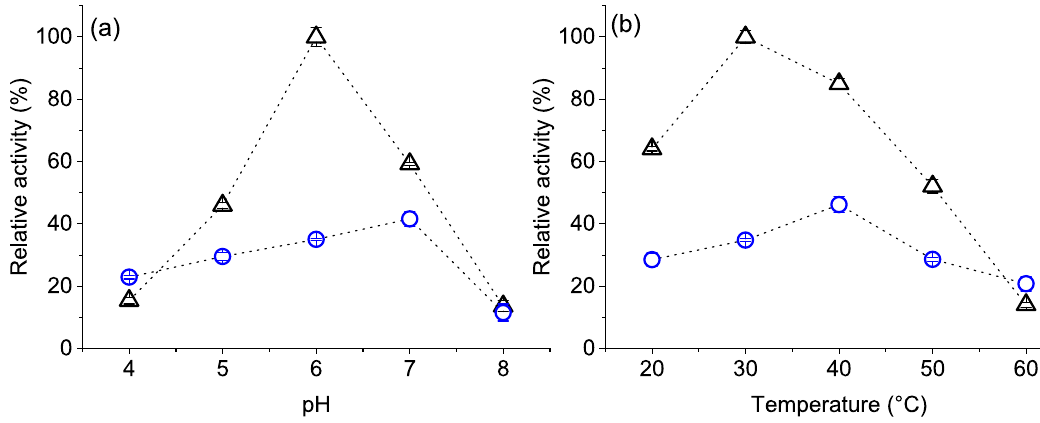
Figure 7. Effect of ( a ) pH and ( b ) temperature on the activity of tyrosinase containing ink (∆) and printed- rinsed polyamide fabrics (O). Results are expressed as percentages against the highest activity found for each